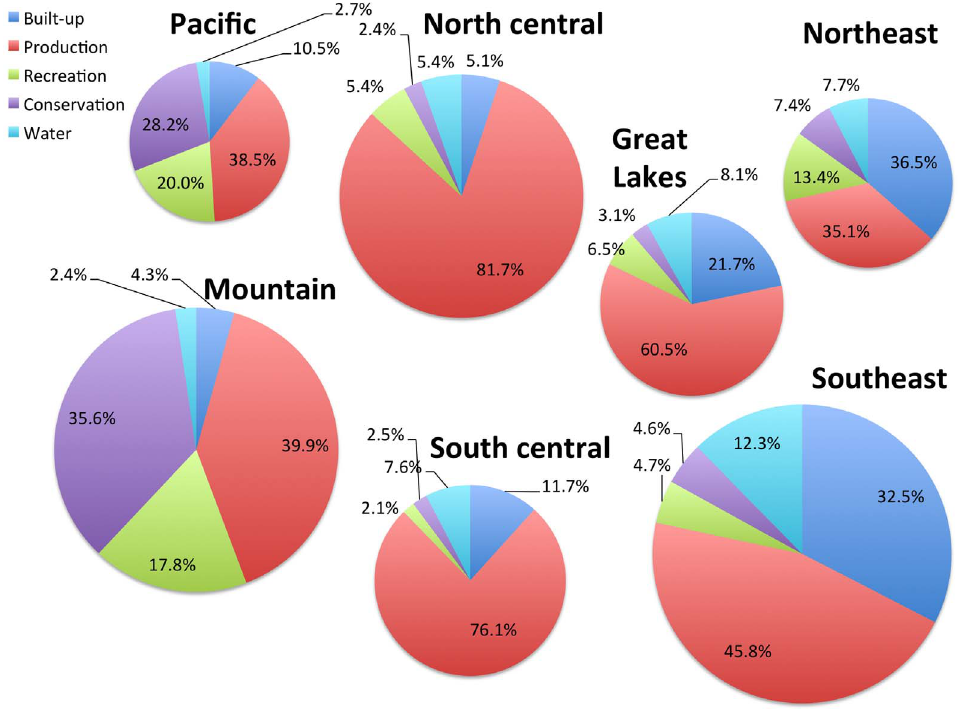
Figure 5. Regional variation of the proportion of major land uses in the conterminous US. The relative extent of 7 regions is depicted by the size of the pie-charts: Pacific (CA, OR, WA); Mountain (AZ, CO, ID, MT, NM, NV, UT, WY); North central (IA, KS, MN, MO, ND, NE, SD); South central (AR, LA, OK, TX), Great Lakes (IL, IN, MI, OH, WI), Northeast (PA and northeastern states), Southeast (DE, KY, WV and southern states). Land in productive uses dominated the major land uses for all regions but the Northeast, which was narrowly dominated by built-up uses. The proportion of land in recreation and conservation land uses exceeded 10% for the Pacific, Mountain, and Northeast regions. Note: ‘‘water’’ is not a land use per se, and includes both water and wetland cover